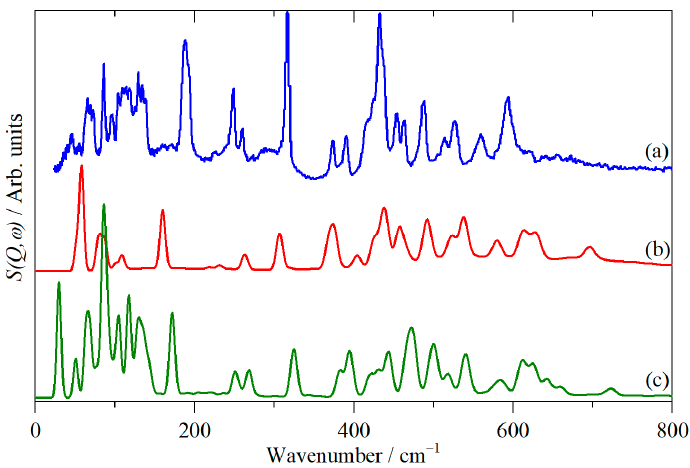
Figure 3. Comparison of observed and calculated INS spectra of Fe 2 (CO) 9 . ( a ) Experimental, ( b ) gen- erated from an isolated molecule DFT calculation and ( c ) generated from a periodic-DFT calculation of the complete unit cell at the Brillouin zone Γ -point.